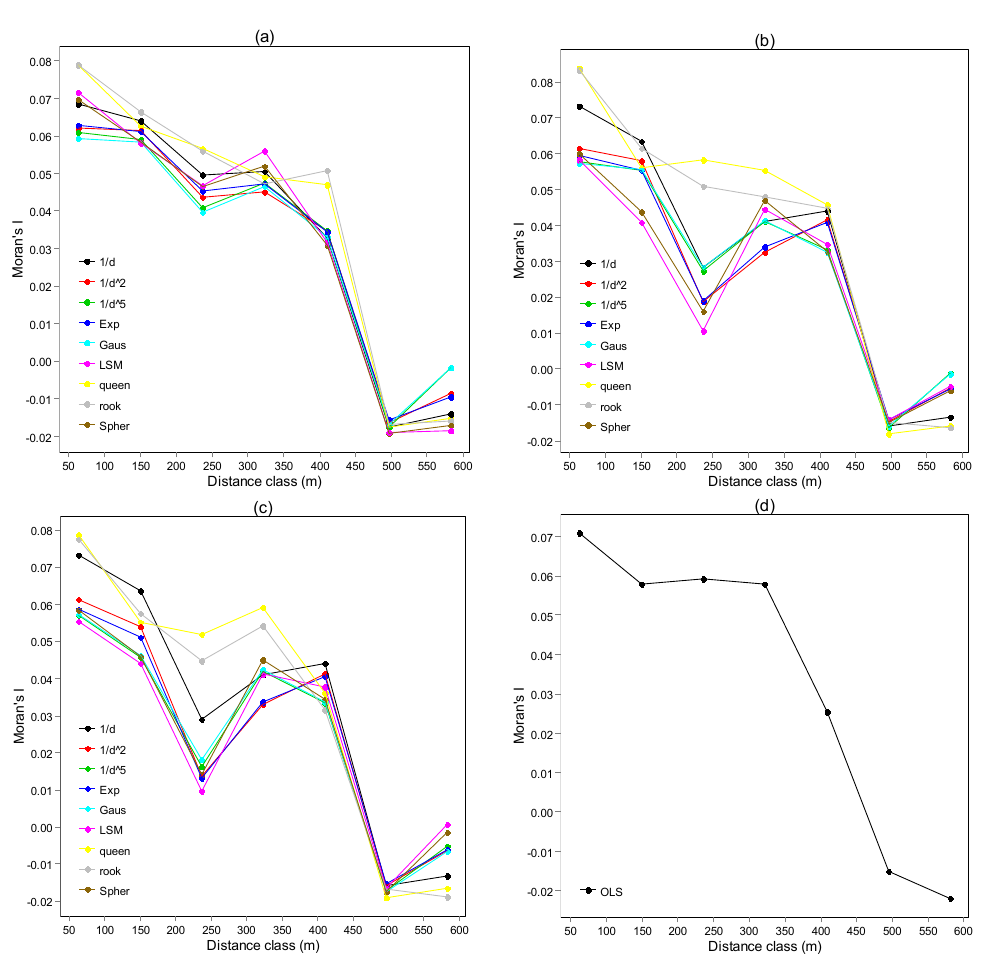
Figure 3. Correlograms of model residuals using three simultaneous autoregressive (SAR) models with nine spatial weight matrices and the ordinary least squares (OLS) model for ( a ) spatial lag model; ( b ) spatial Durbin model; ( c ) spatial error model; and ( d ) OLS model.